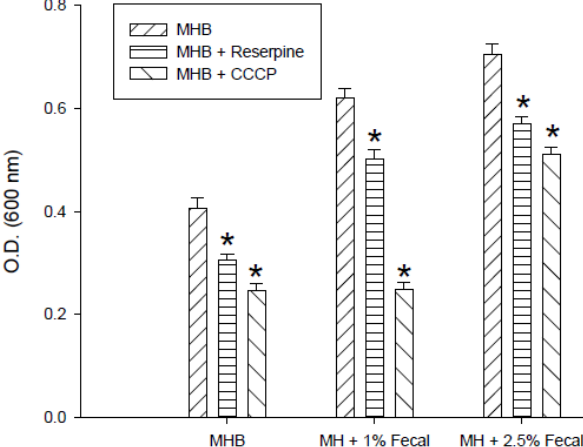
Figure 3. Effects of reserpine (33 µM) and carbonyl cyanide- m -chlorophenylhydrazone (CCCP) (10 µM) on the growth of S. enterica with 0.1  g/mL enrofloxacin in Mueller-Hinton broth (MHB) containing 1% and 2.5% sterilized human fecal extract in the third passage. * Indicates statistically significant differences from control ( p <